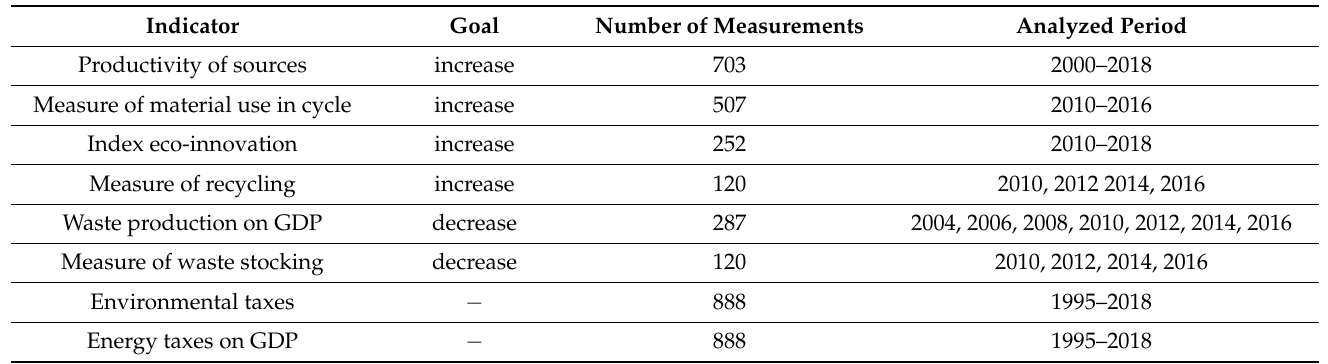
Table 1. Structure of collected